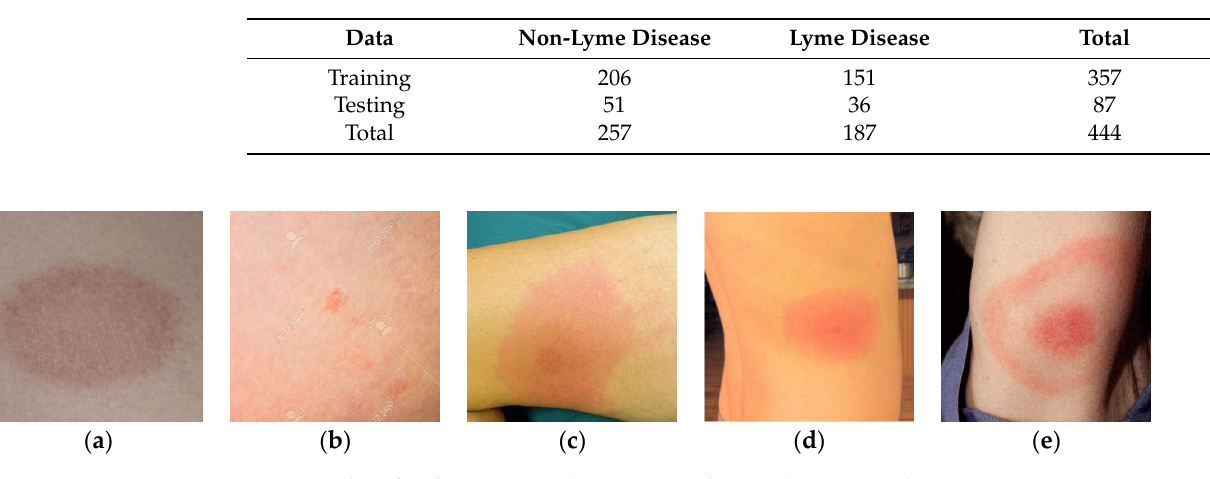
Figure 12. Examples of rash images. ( a , b ) Non-Lyme disease; ( c – e ) Lyme disease. Table 7. The construction of the rash image